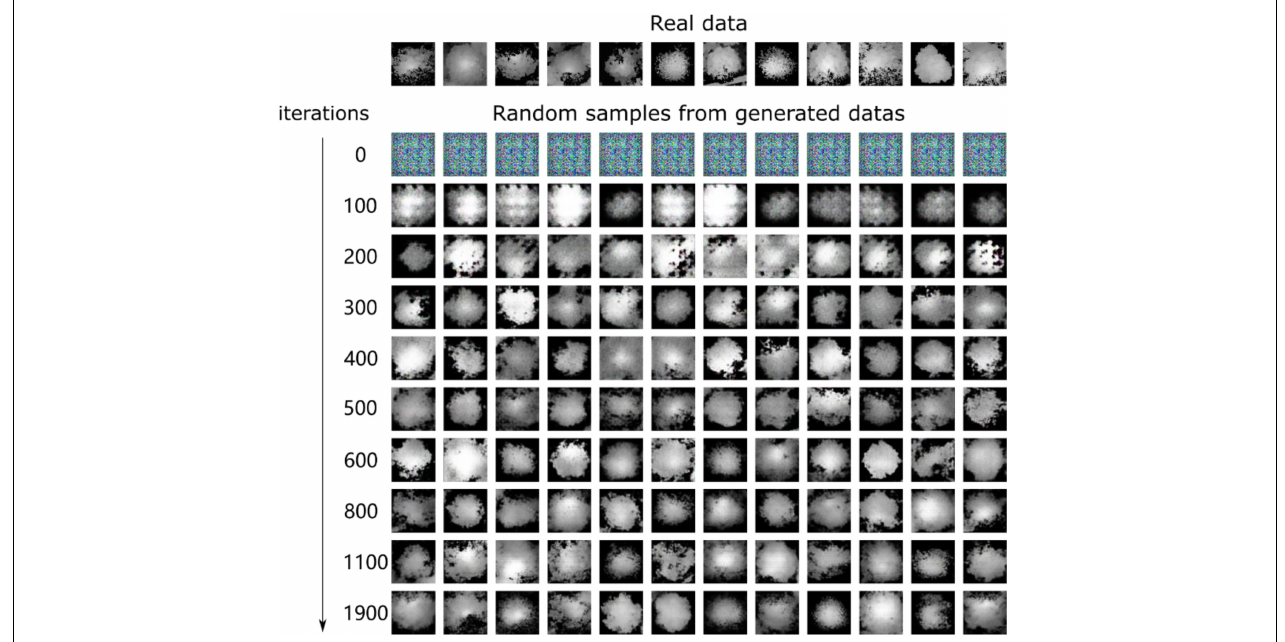
FIGURE 13 | Heightmaps generated using WGAN-GP with an increasing number of iterations. At the 0th, 100th, and 200th iterations, the generated data distributions are very different from the real data distributions. However, as the training process continues, the generator can produce heightmaps of tree crowns with the same or nearly the same quality and successfully fool the discriminator in